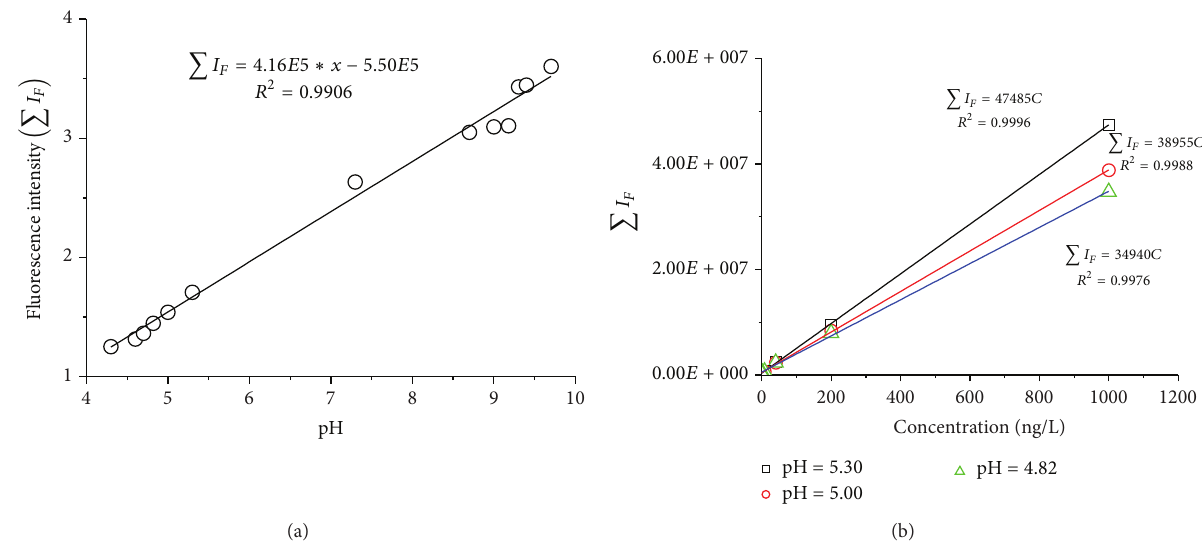
) variations of 50ng/L BDE 47 as a function of pH (a) and the influence of pH on the slope of Figure 4: Fluorescence intensity (∑𝐼 𝐹360∼500 nm the linear correlations between the fluorescence intensity and BDE 47 concentration (b).